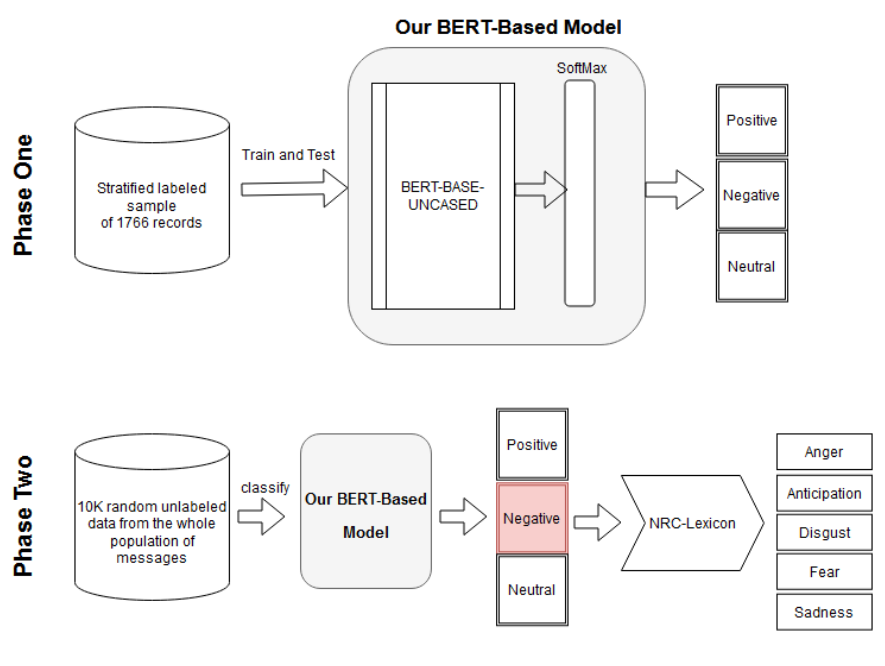
Figure 1. The proposed two-phase approach for emotions analysis.